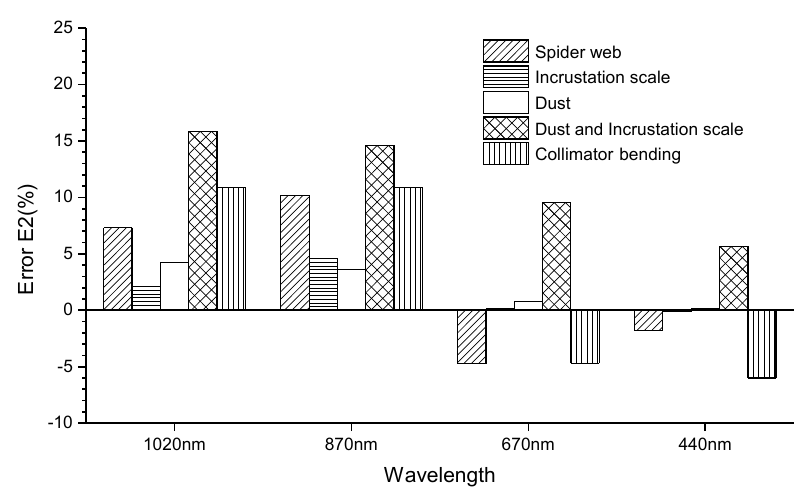
Figure 7. Error of AOD retrieved at 1020 nm, 870 nm, 670 nm and 440 nm between the experimental instruments and the reference instrument under the condition of the instruments’ status being “affected” ( i.e. , affected by one of the factors indicated in the key).